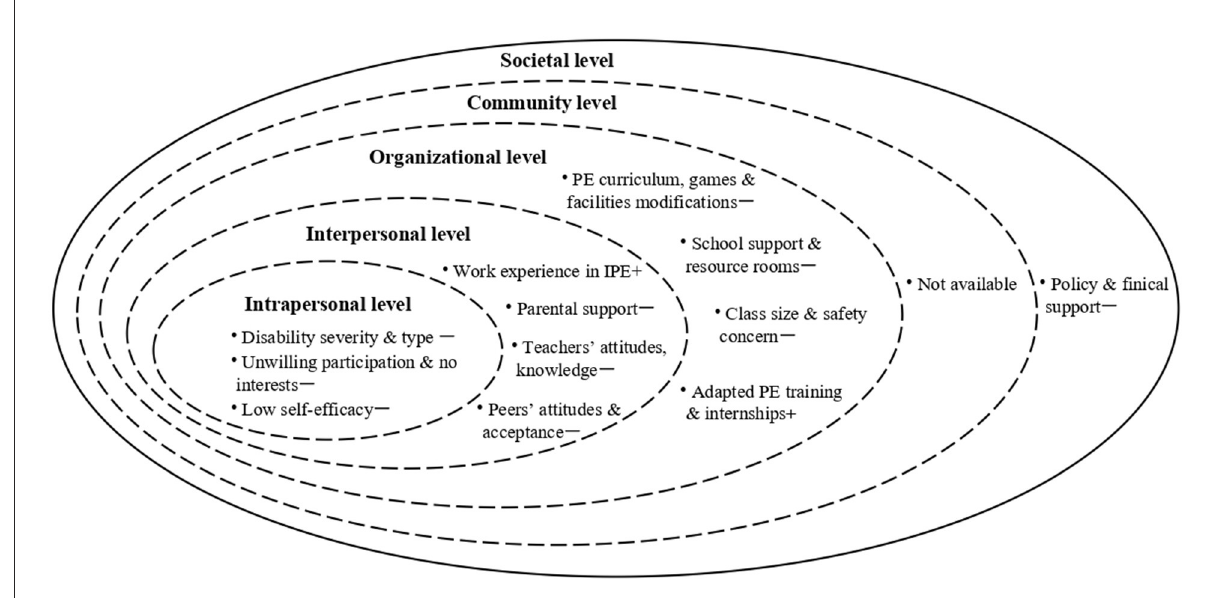
FIGURE3 Factors affecting the IPE participation for students with SEN within the social ecological model in China. + , positive association; - , negative